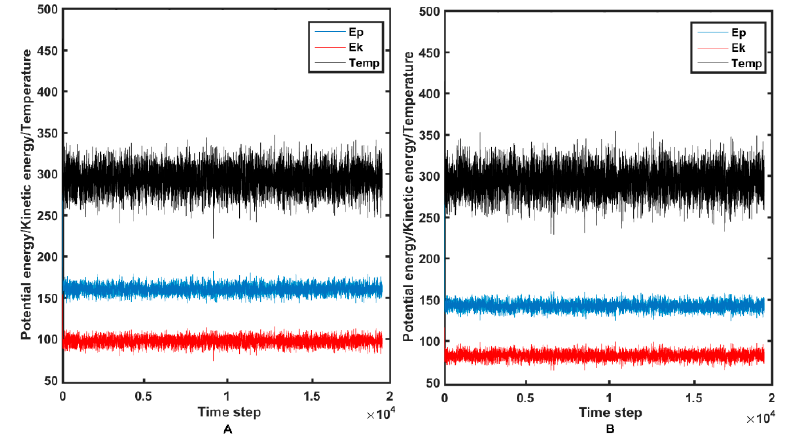
Figure 11. Kinetic, potential energy variations and temperature changes in the molecular dynamics simulations (MDS) of molecule 14a ( A ) and BVM ( B ).